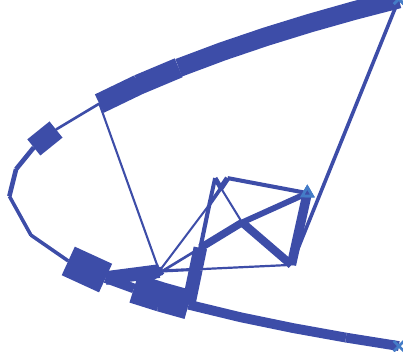
Figure 14. Representation of the optimal compliant structure configuration.